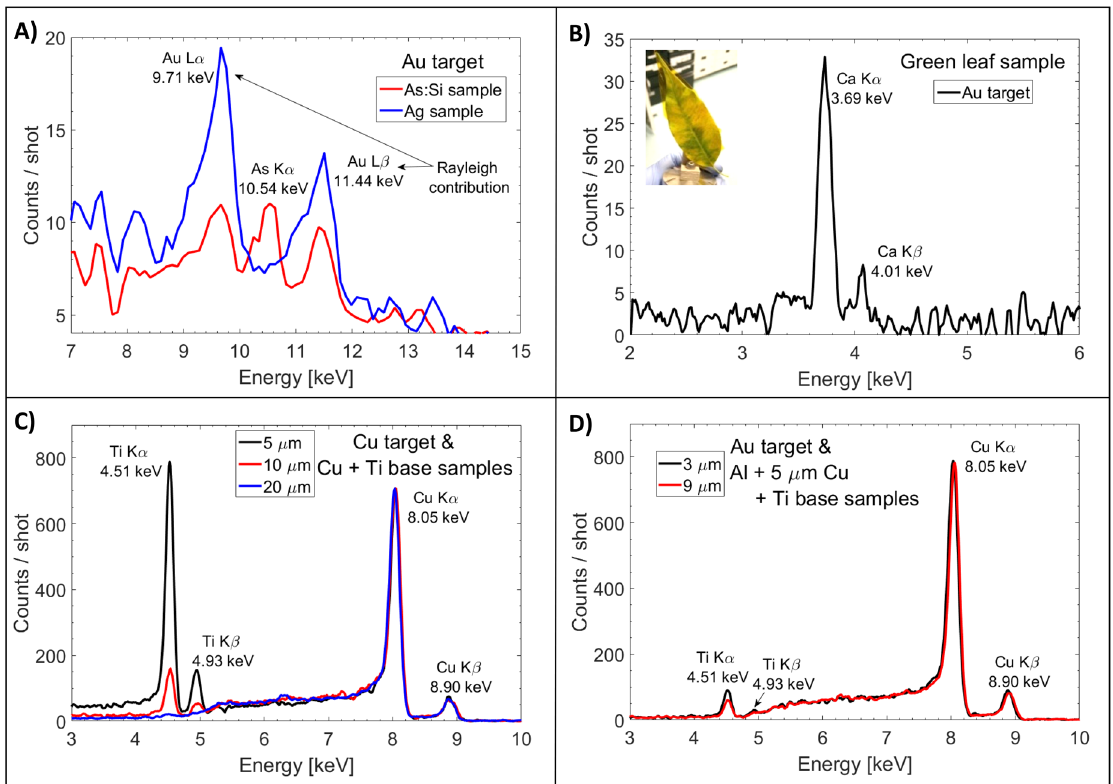
Figure 4. X-ray spectra obtained when irradiating different samples using the laser-based sources produced with an Au or Cu laser-interaction target. ( A ) Arsenic doped Si wafer sample (red) compared with an Ag sample (Au interaction target). ( B ) green leaf sample (Au interaction target). ( C ) 5, 10, and 20 µm Cu layer on a Ti substrate (Cu interaction target). ( D ) 3 and 9 µm Al layer lying on a 5 µm Cu layer on a Ti substrate (Au interaction